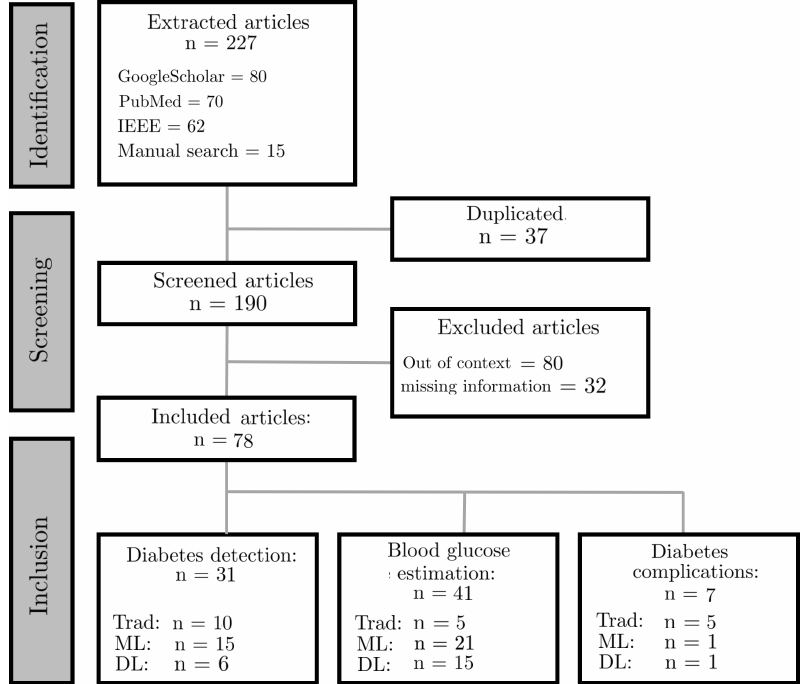
Figure 1. The PRISMA flow diagram. ML: machine learning approaches. Trad: traditional approaches. DL: deep learning